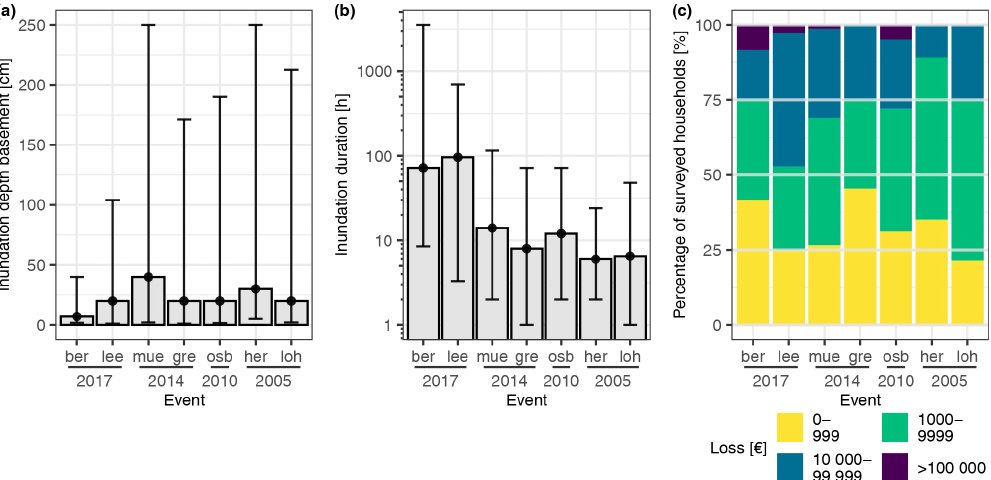
Figure 8. Comparison of (a) inundation depth, (b) inundation duration and (c) building loss between pluvial flood events in seven municipal- ities as reported in the surveys Berlin-2017 (ber), Leegebruch-2017 (lee), Muenster-2014 (mue), Greven-2014 (gre), Osnabrueck-2010 (osb), Hersbruck-2005 (her) and Lohmar-2005 (loh). Points indicate median values, while whiskers show 5% and 95%